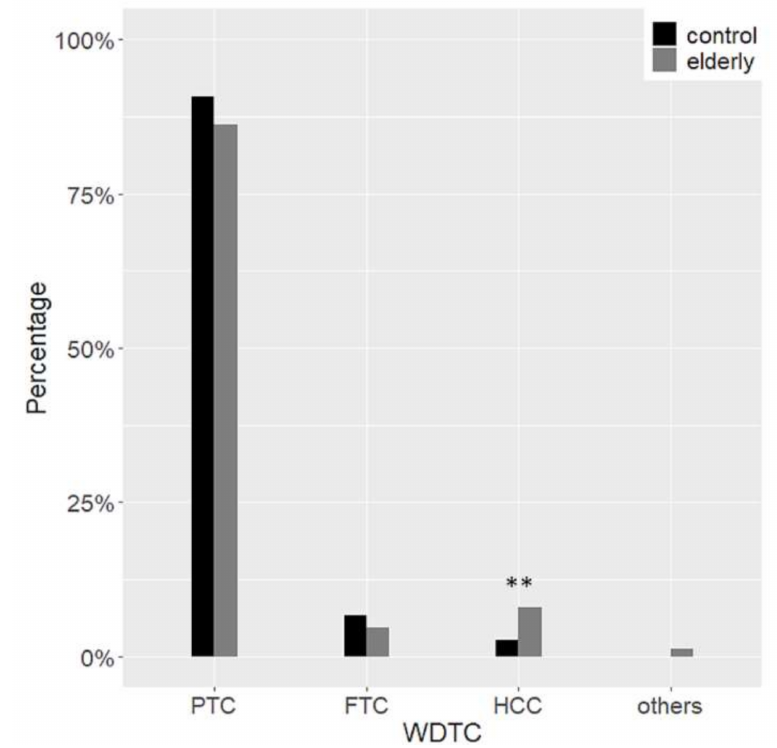
Figure 5. Follicular-derived well-differentiated tumors: differences between the elderly (grey) and the control (black) group. WDTC, well-differentiated thyroid carcinoma; PTC, papillary thyroid carcinoma; FTC, follicular thyroid carcinoma; HCC, Hürthle cell carcinoma ** p <